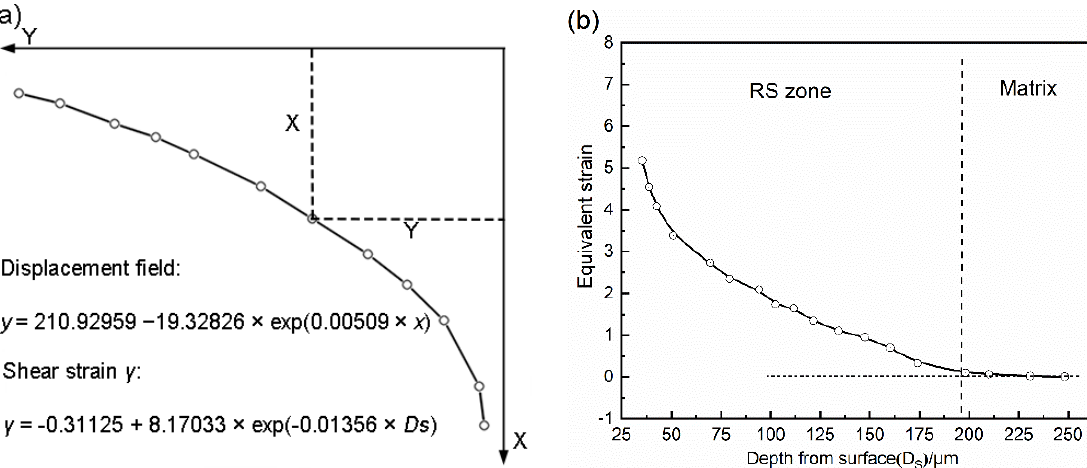
Figure 7. Curves of ( a ) plastic flow line displacement field and ( b ) shear strain along with the